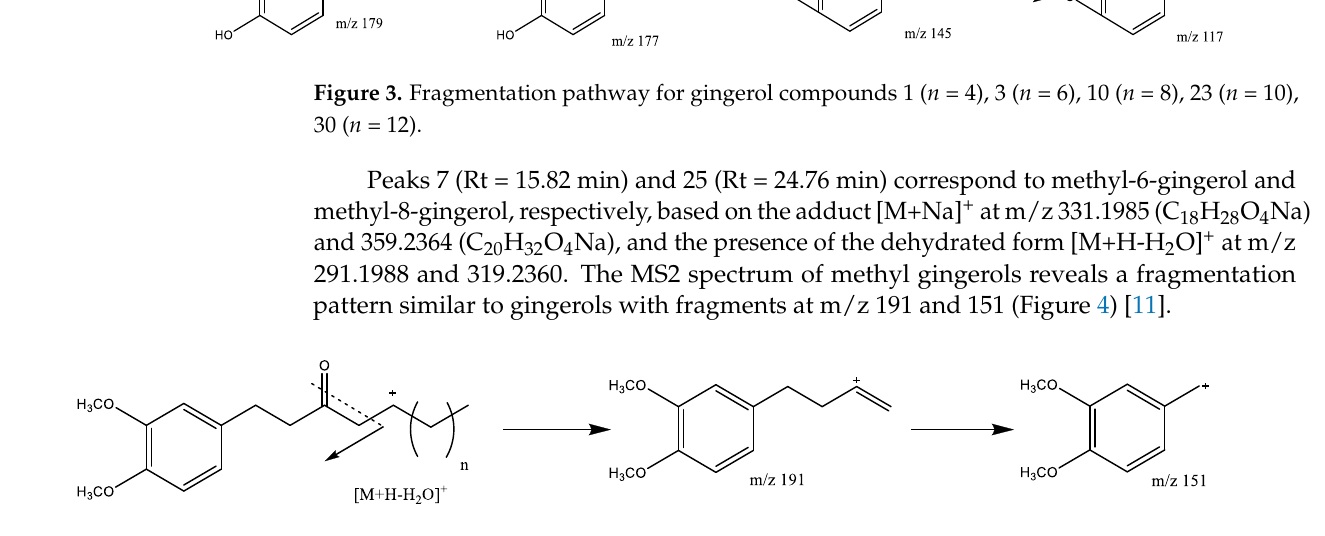
Figure 4. Fragmentation pathway for methylgingerol compounds 7 ( n = 6), 25 ( n = 8). The third group is composed by shogaols, compounds that correspond to the dehy- drated form of gingerols, conversion that is mainly produced at higher temperature [25].